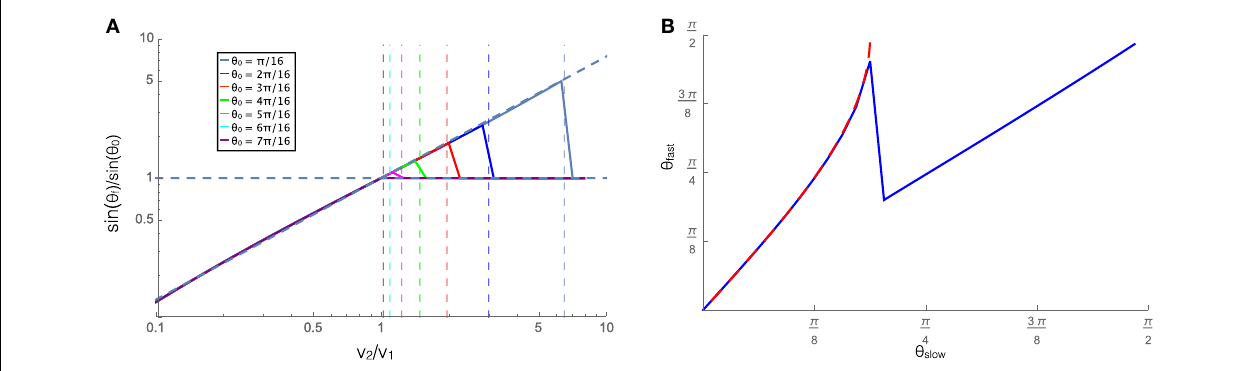
FIGURE 4 | (A) The ratios of the sines of the incident ( (cid:18) 0 ) and refracted ( (cid:18) f ) angles plotted against the ratios of the equilibrium speeds in each material, with v 1 = 0.001. The vertical lines show the value of velocity ratio where the refracted angle would become > (cid:25) /2, resulting in a reflection, for each initial angle shown in the legend. When the cluster is reflected (right side of the vertical dashed lines), the horizontal line at sin (cid:18) f /sin (cid:18) 0 = 1 shows that the reflected angle is equal to the incident angle. (B) The angle that the trajectory makes (with respect to the normal to the interface) on the faster ( (cid:18) fast ) and slower ( (cid:18) slow ) substrates for a cluster moving from the slower substrate to the faster one was shown in blue, and the similar angles for a cluster moving from the faster to the slower substrate were shown in red dashed line. In both these cases, v 1 = 0.001 and v 2 = 0.002, and C = 1.